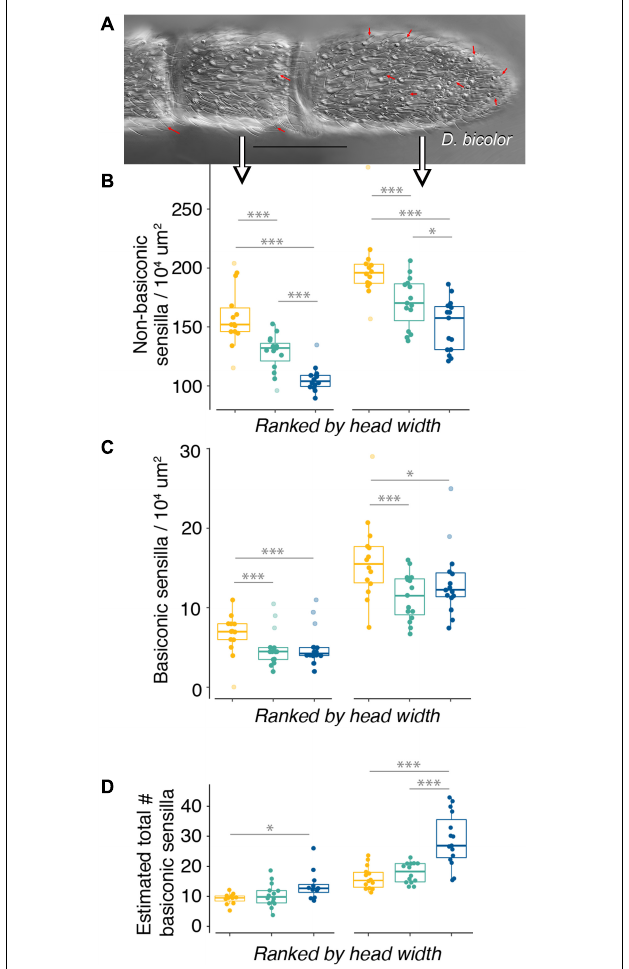
FIGURE 3 | Basiconic sensilla density specifically does not scale with body size. (A) Microphotograph (63 × oil immersion lens) of distal antennal segments [penultimate (left) and club (right)] of Dorymyrmex bicolor ; red arrows point to basiconic sensilla; scale bar = 100 µ m; large arrows point at the respective data sets in (B,C) . (B) Non-basiconic sensilla density decreases with increasing body size on both the penultimate and club segments. (C) Basiconic sensilla density does not decrease with increasing body size, specifically in the comparison of Dorymyrmex species. (B,C) Show sensilla density for the penultimate (left) and club (right) antennal segments; outliers excluded from analysis shown with decreased saturation. (D) Estimated total number of basiconic sensilla when mean basiconic sensilla density is multiplied by mean surface area for each segment (penultimate, left; club, right) for individual ants; data shown does not include outliers. Statistical comparisons of sensilla density across species made using a generalized linear model with a quasi-Poisson distribution followed by ANOVA and post hoc comparisons using Tukey’s Honestly Significant